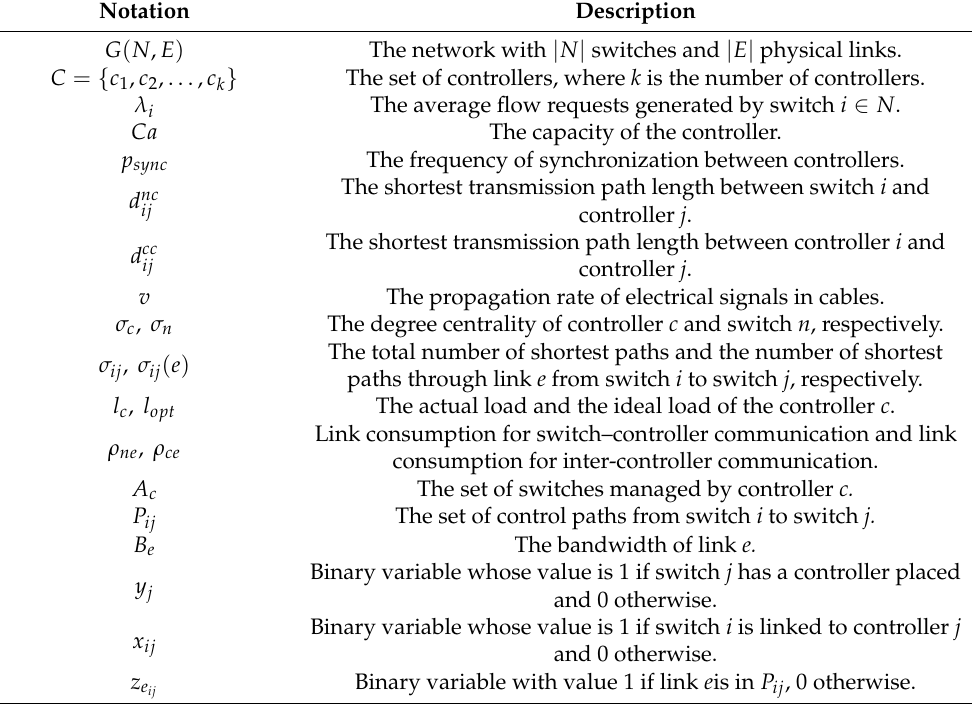
Table 2. Summary of